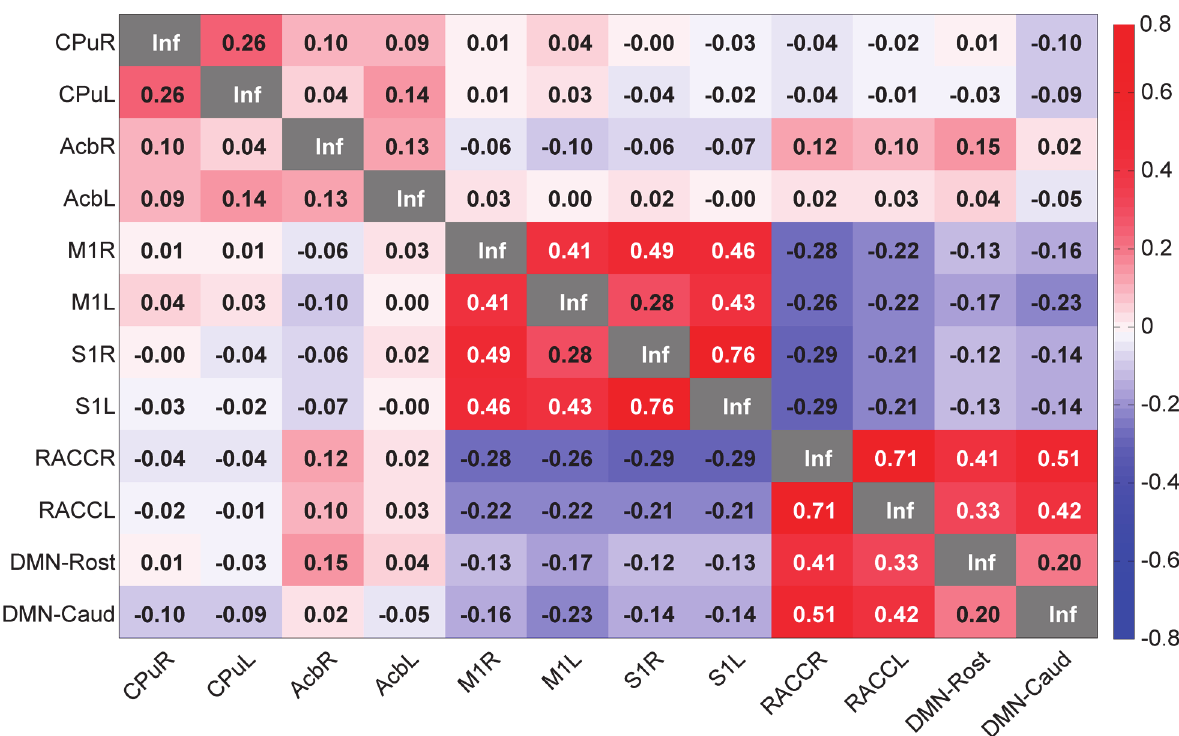
Fig 10. Rat Seed Correlation Matrix. Note the high correlations between the somatosensory and motor regions as well as the high correlations between the seeds in the DMN. CPu = Caudatus Putamen, Acb = n. Accumbens, M1 = primary motor cortex, S1 = primary somatosensory cortex, RACC =